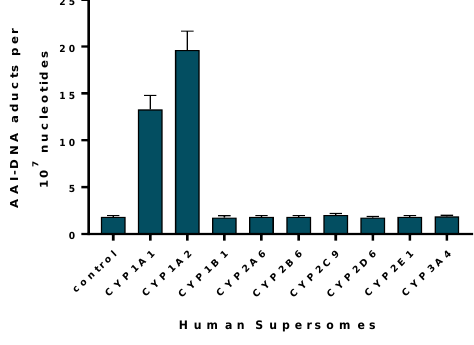
Figure 5. AAI-DNA adduct formation by human CYP enzymes. Control, the POR enzyme was only present [adapted from 115,120].